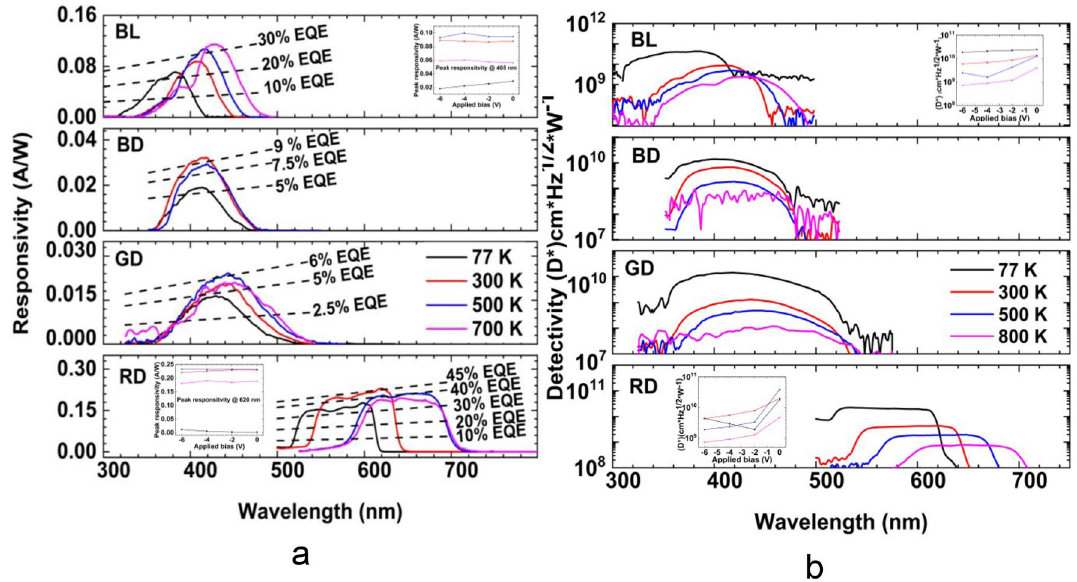
Figure 4. ( a , b ) Temperature-dependent responsivity and detectivity, respectively, of blue for lighting and display, green for display, and red for display at zero bias. Insets: Responsivity and detectivity as a function of different